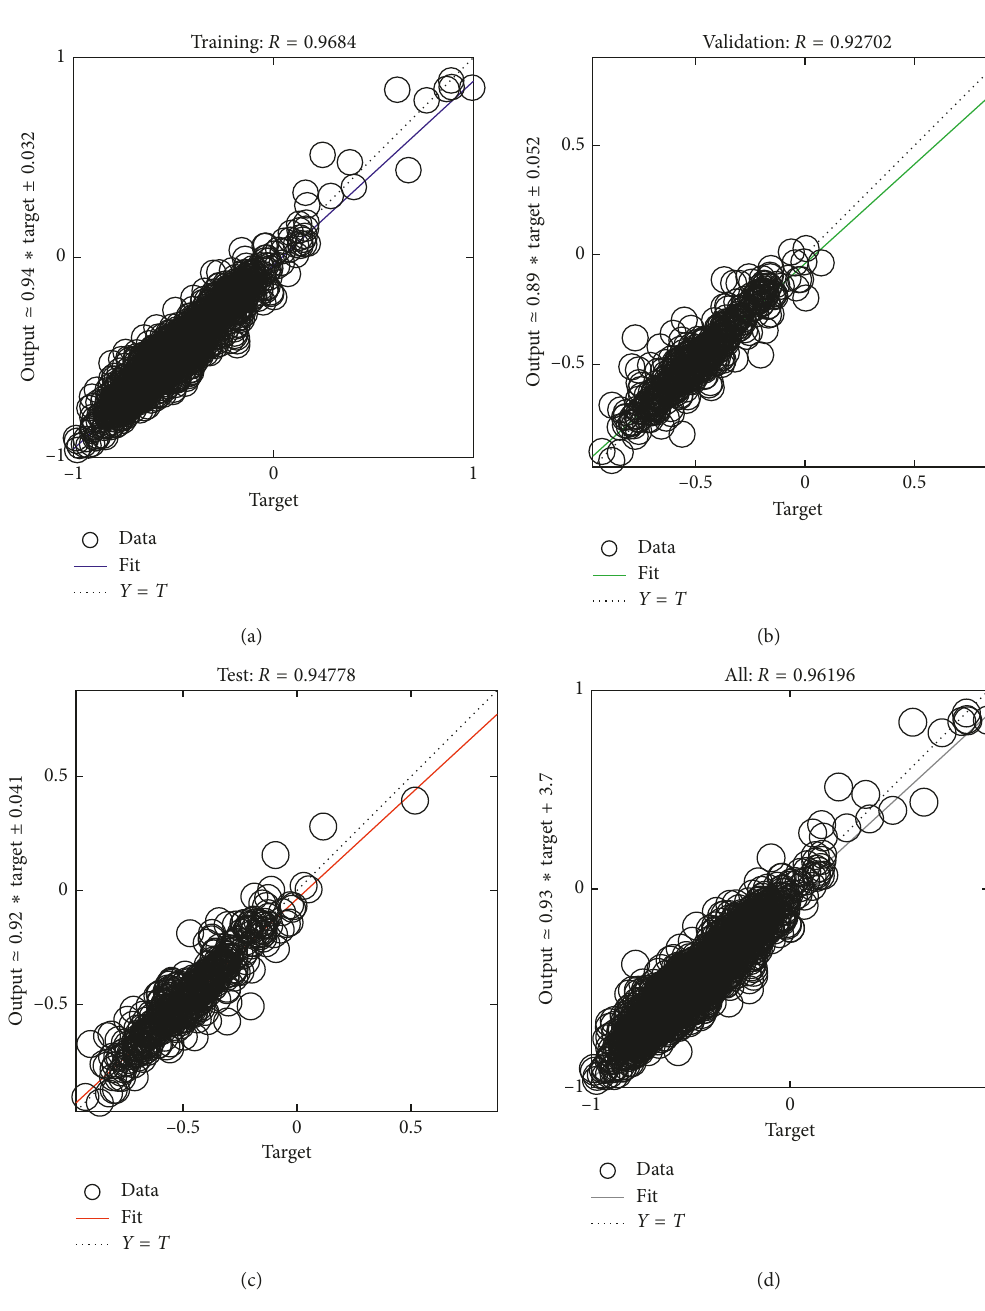
Figure 6: Results of training, validation, and